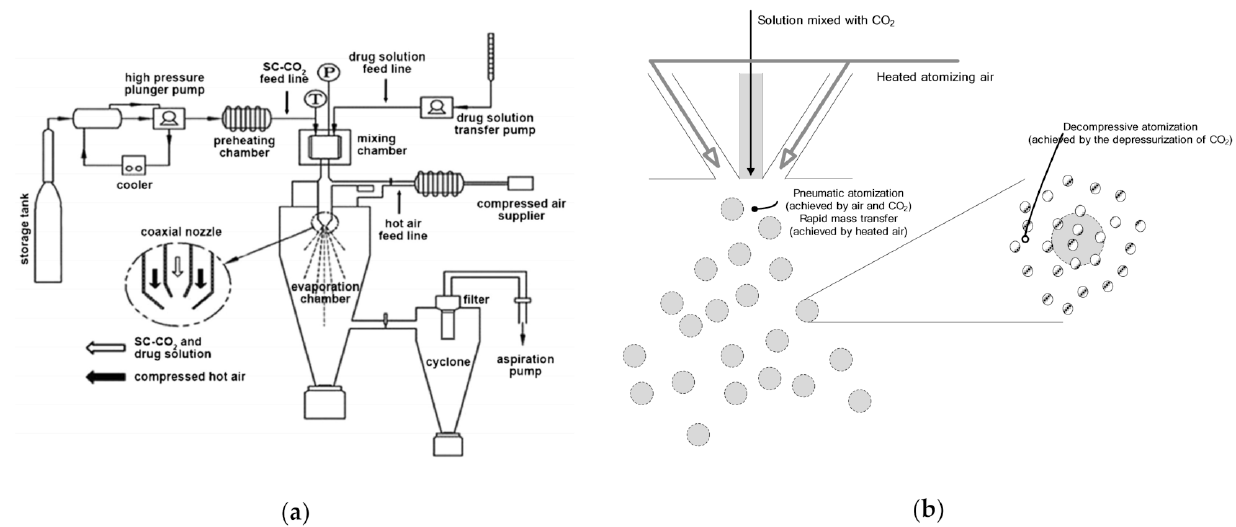
Figure 1. Schematic diagram of ( a ) the apparatus (reprinted from Reference [25] with permission, Elsevier 2015) and ( b ) the atomization mechanism the SA-SD